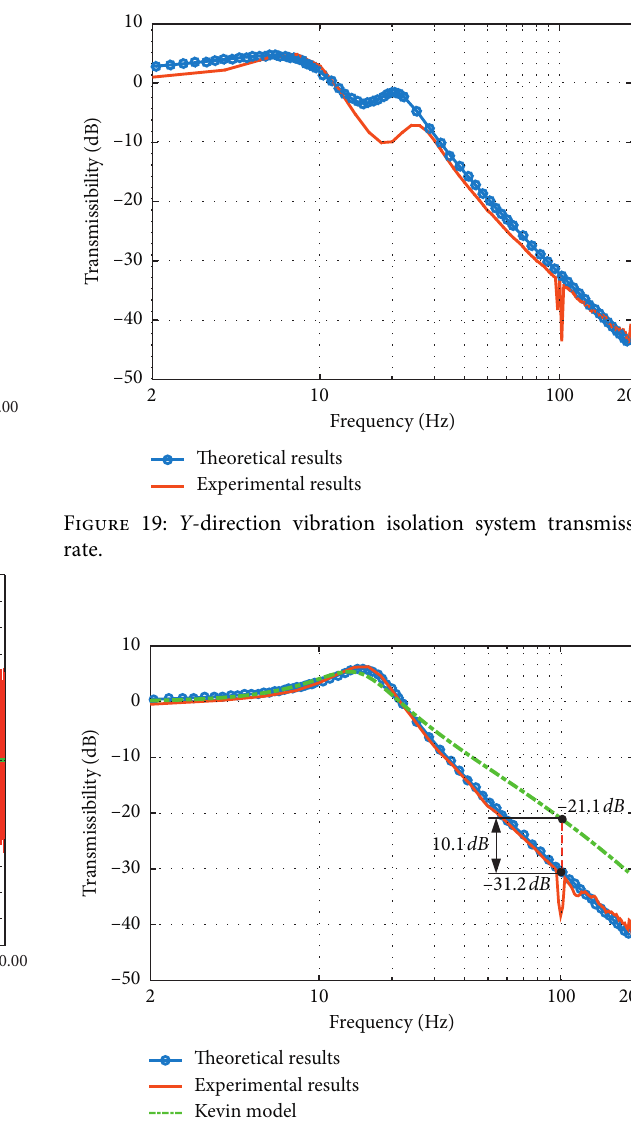
Figure 20: Comparison of the transmissibility of the proposed vibration isolation device with that of a Kevin model in Z